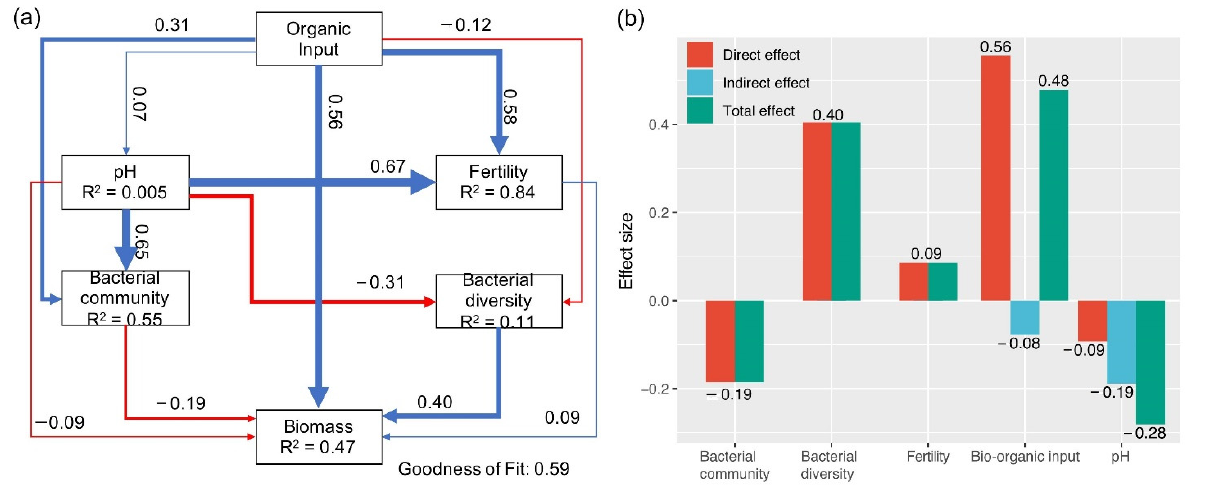
Figure 7. The relationship between bacterial diversity, community structure, soil pH, fertility, BOF input and tea biomass. ( a ) Path model outputs: the numbers on the arrows represent standardized path coefficients. The value of each path coefficient is indicated by the arrow width; blue and red arrows indicate positive and negative effects, respectively. Values of R 2 indicate the variance explained by the model. ( b ) The standardized path coefficients for direct and indirect effects on the bacterial